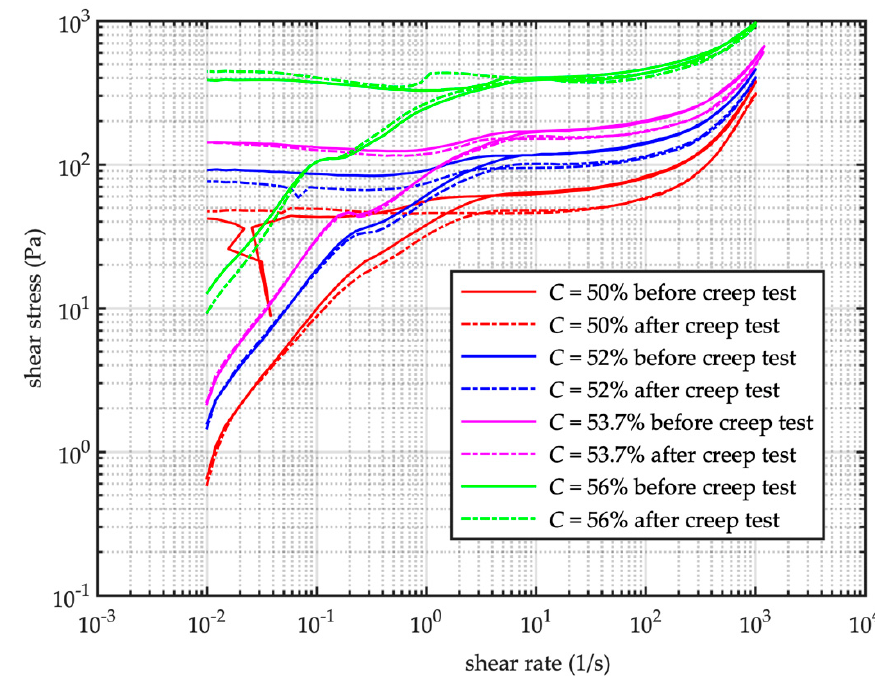
Figure 6. Flow curves before and after creep test, for different value of grain concentration C (runs F21, F22, F5, F6, F14, F15, F18, F19—see Table 1—in the legend from the top to the bottom).